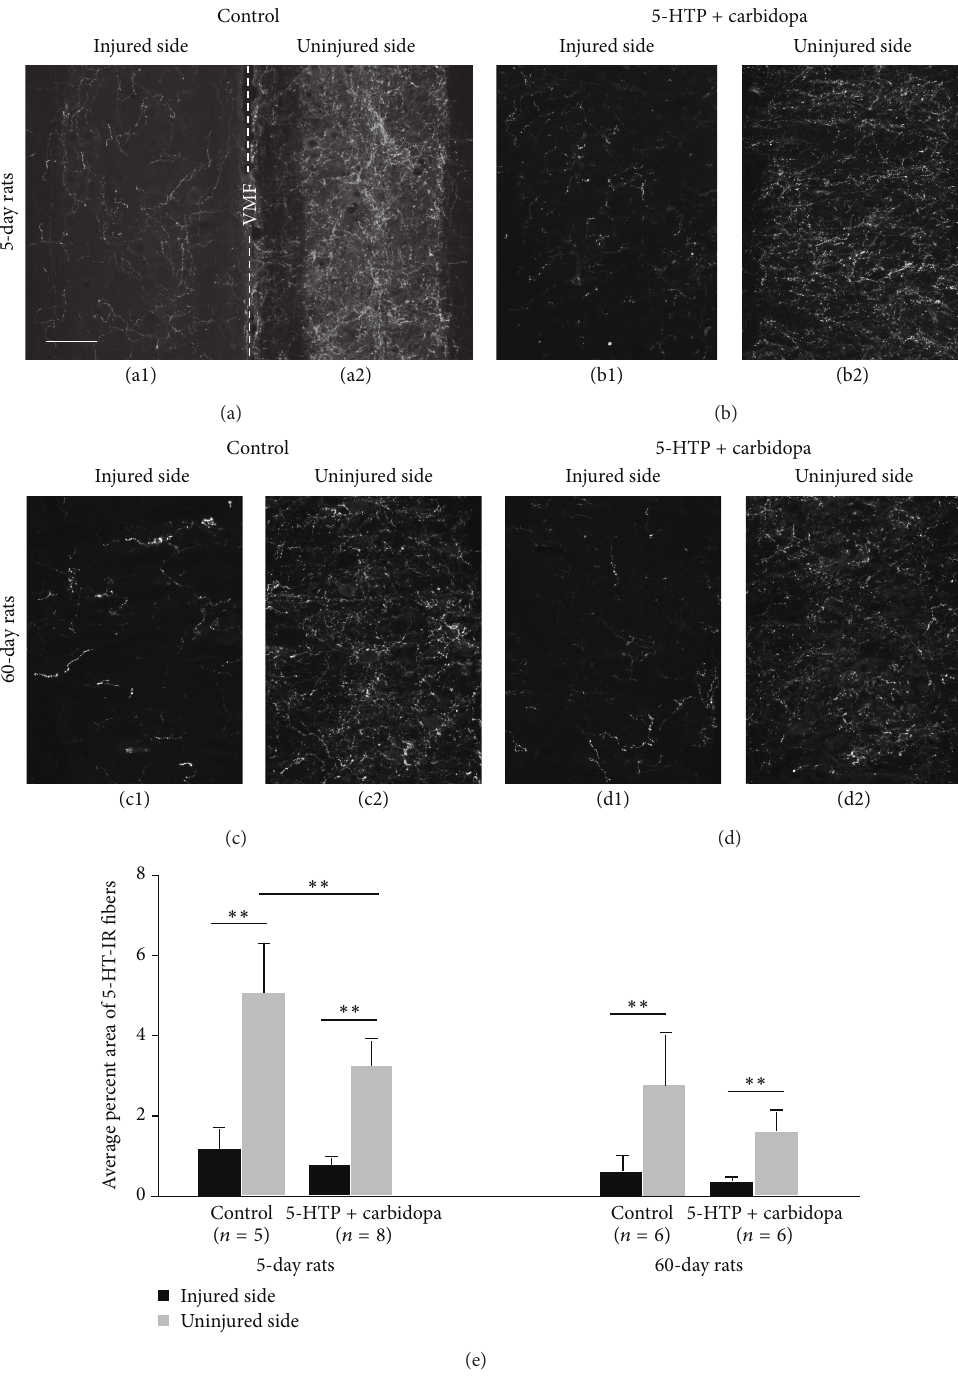
Figure 2: 5-HT-immunoreactive (IR) nerve fibers in the ventral horn motoneuron region in the sacrocaudal spinal cord on the injured and uninjured side in different animal groups. (a1–d2) Photomicrographs of 5-HT-IR fibers in 5-day untreated group (a1, a2) and 5-HTP plus carbidopa treated group (b1, b2) and in 60-day untreated group (c1, c2) and 5-HTP plus carbidopa treated group (d1, d2). (a1) and (a2) were from the same horizontal section. Dashed line indicates the midline. VMF: ventral median fissure. Other pairs of photomicrographs were from different sections. Scale bar in (a1), 100 𝜇 m. (e) Quantitative data of the density of 5-HT-IR fibers in different animals groups. ∗∗ 𝑃 < 0.01